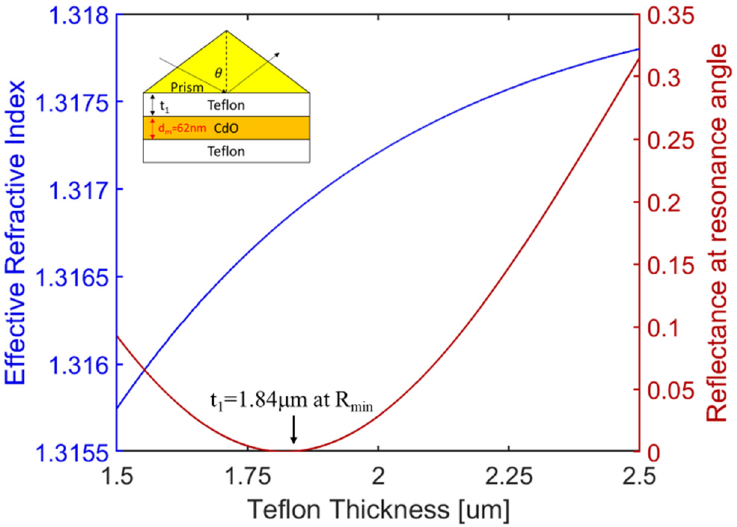
Figure 5. Modal index and reflectance at the resonance angle as a function of the Teflon thicknesses t 1